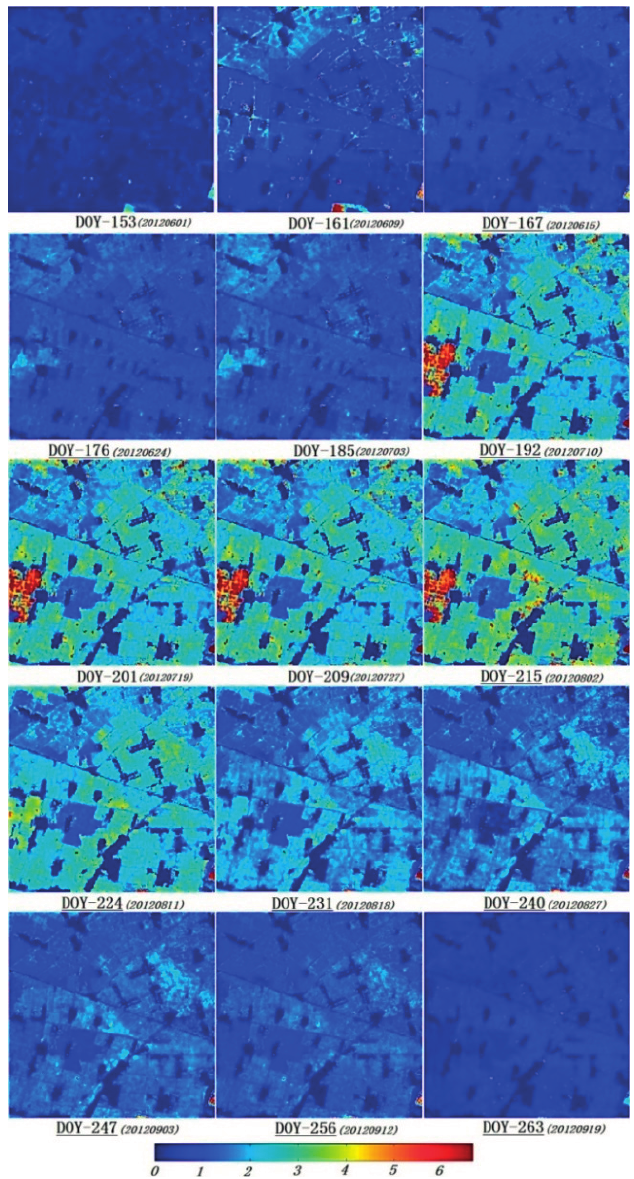
Figure 5. The high-resolution and time-series results for the estimated LAIs from the ASTER and MODIS LAI data for the year 2012; the underlined data were estimated from the ASTER and MODIS LAI